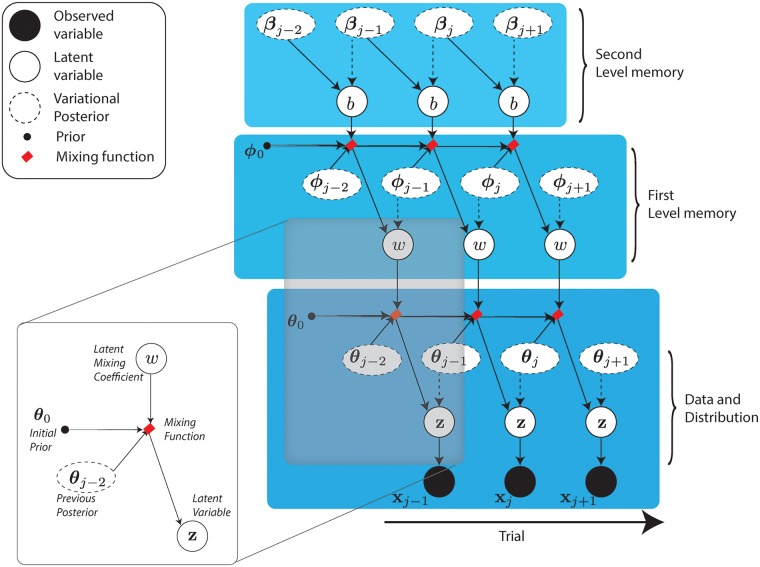
Directed Acyclic Graph of the HAFVF model.Plain circles represent observed variables, white circles represent latent variables and dots represents prior distribution parameters. Dashed circles and dashed arrows represent approximate posteriors and approximate posterior dependencies. A weighted prior latent node is highlighed.